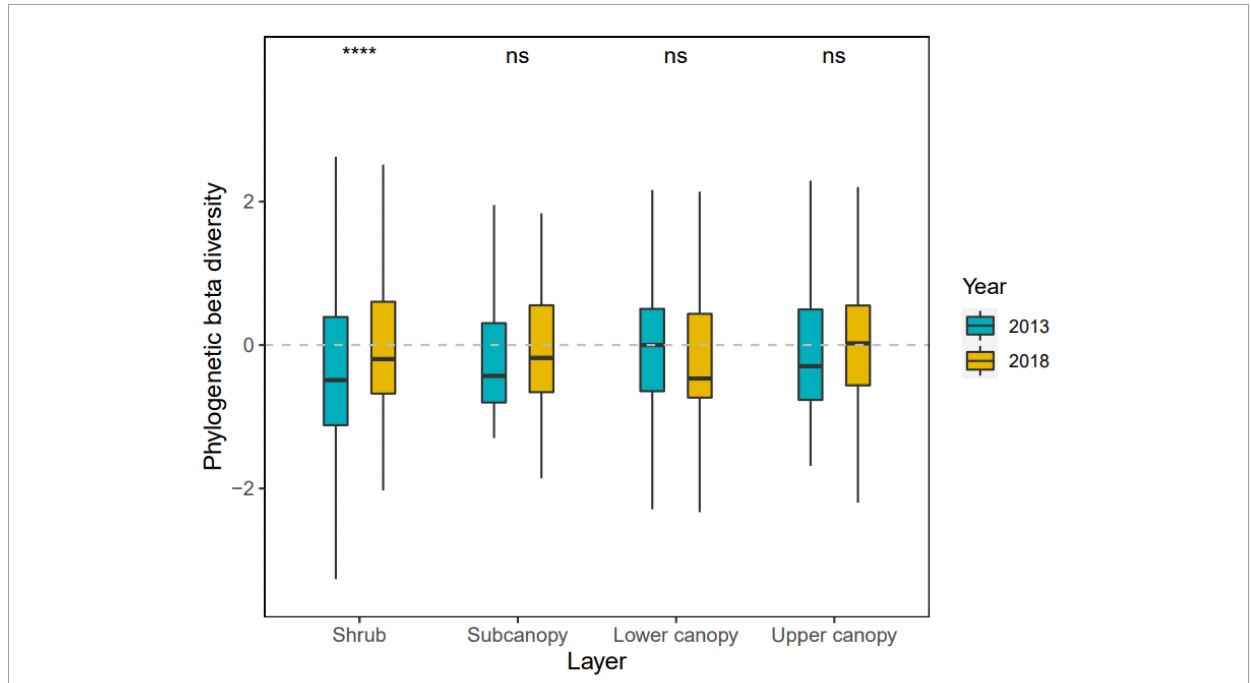
FIGURE4 Changes of phylogenetic beta diversity in four vertical stratification in the Dongbaishan forest between 2013 and 2018. ns p > 0.05, * p ≤ 0.05, ** p ≤ 0.01, *** p ≤ 0.001, **** p ≤ 0.0001.